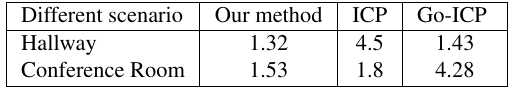
Table 1. Accuracy of different type of indoor environment